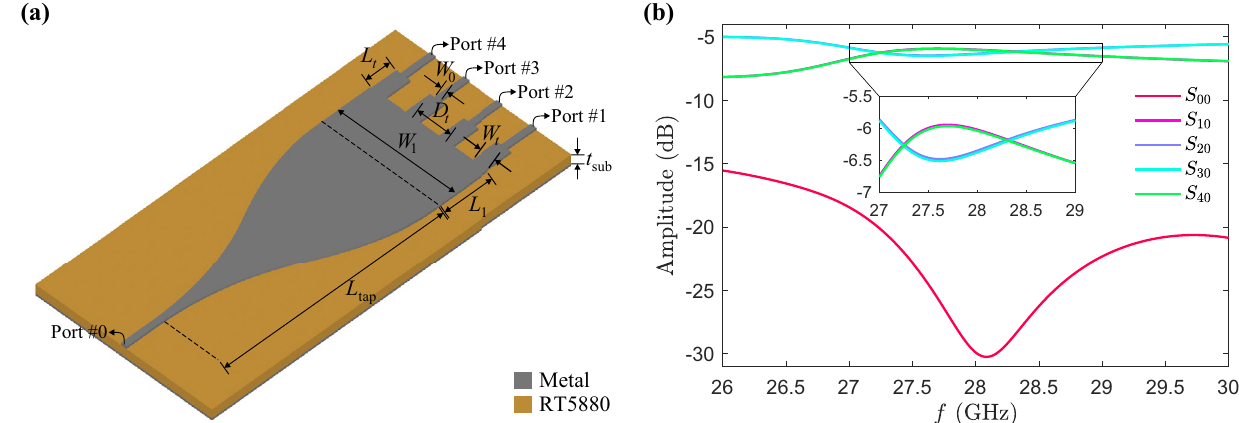
1.68 , W t 0.97 , D t 2.3 , W 0 0.39 and t sub 15 , L 1 3.8 , W 1 8 , L t 0.127 all in = = = = = = = =